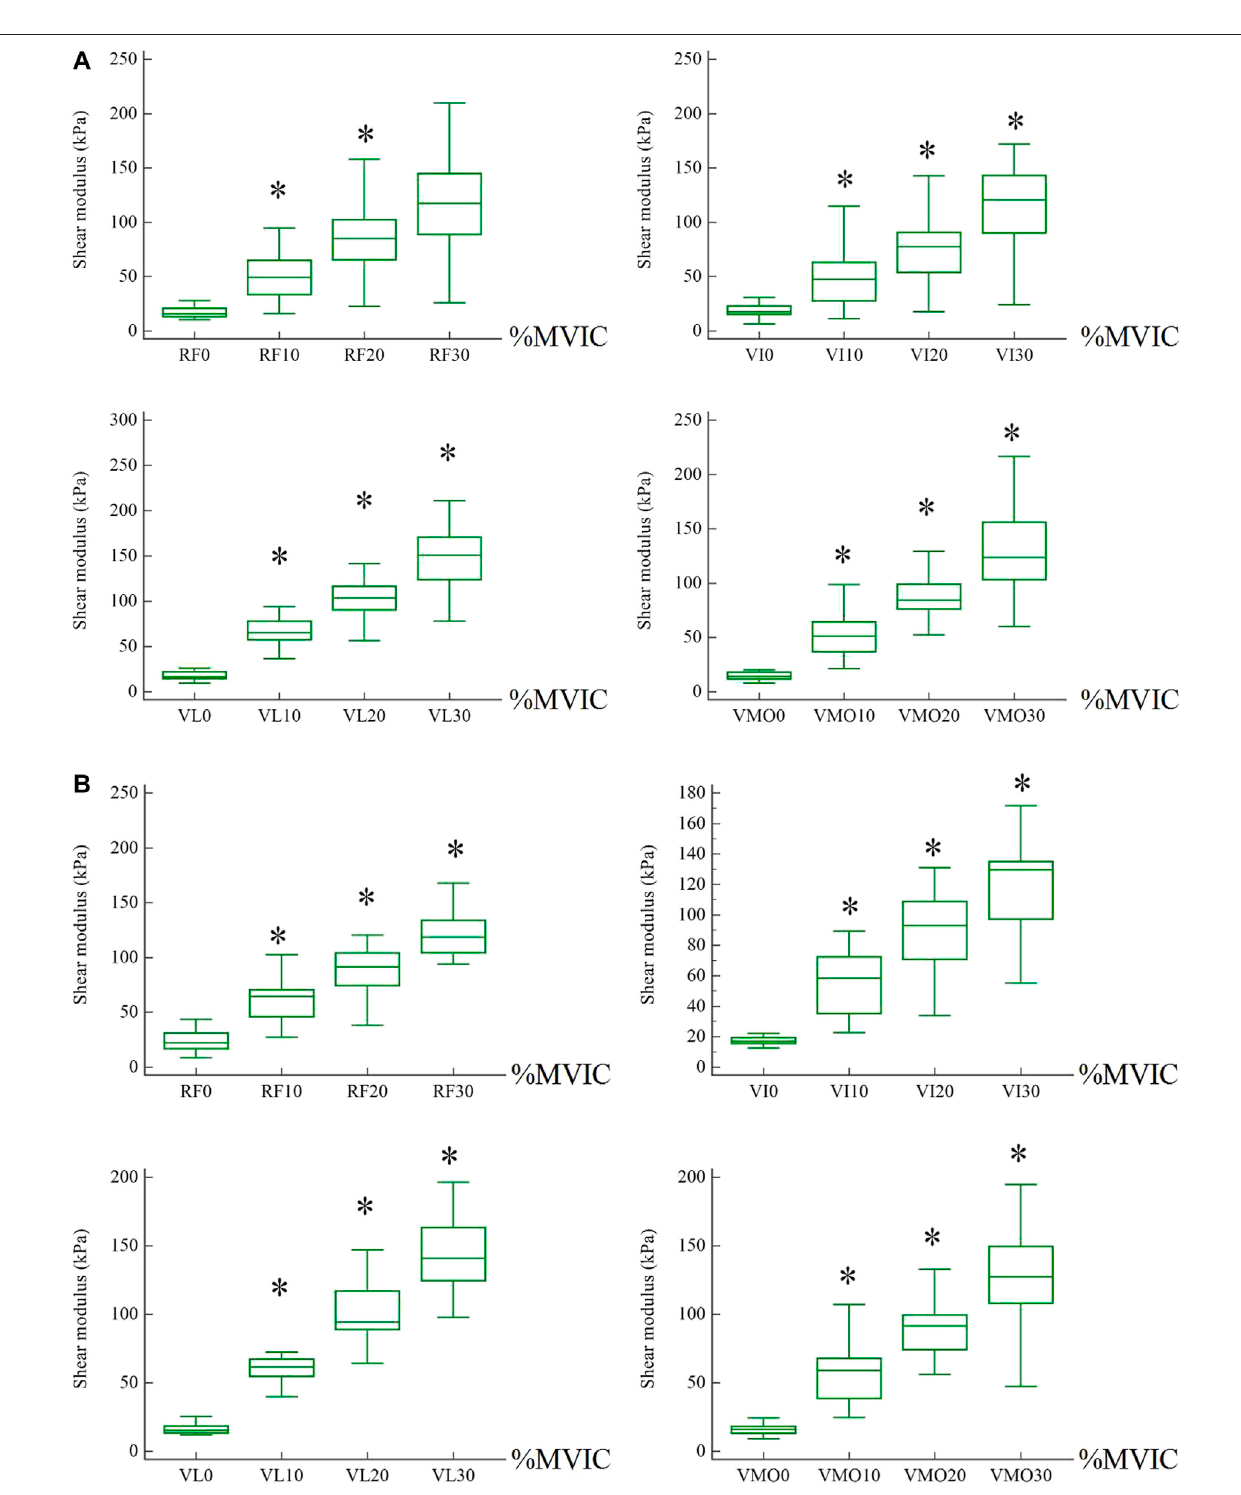
FIGURE 4 | The shear modulus of muscles between different states. * means a signi fi cant difference from a smaller contraction state. (A) Hip was 90 ° . (B) Hip was 0 ° .